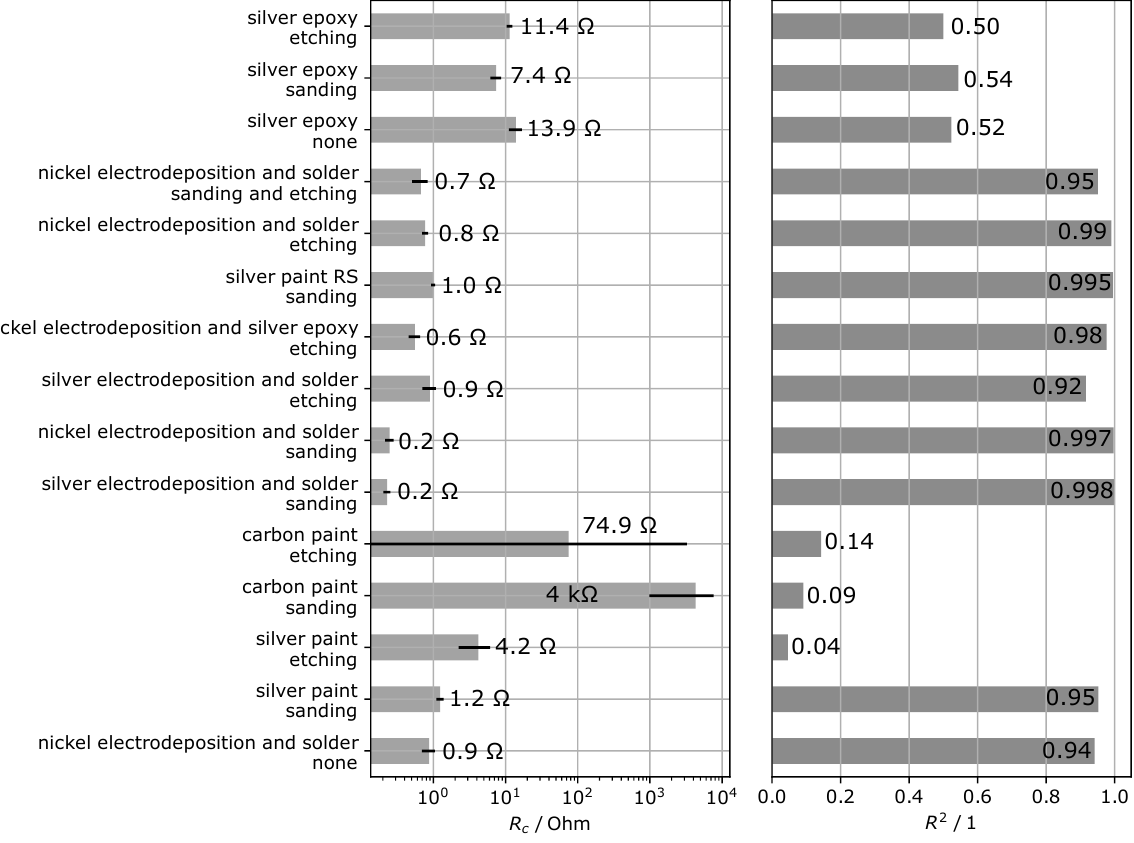
Figure 6. Contact resistances and R 2 for least square fits of the 2-wire resistance over the distance between contacts. The methodology from Todoroki et al. [7] is used to acquire the